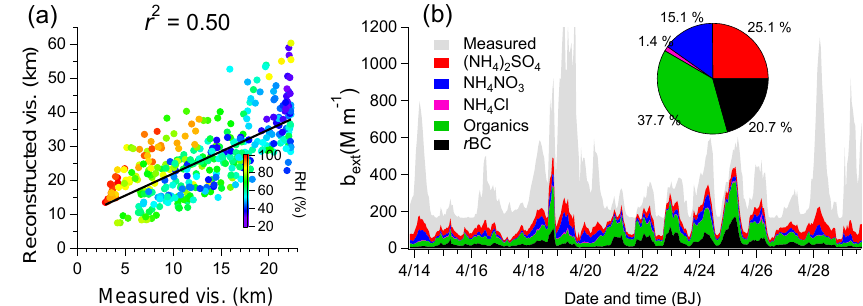
Figure 6. (a) Scatter plot of reconstructed vs. measured visibility (colored by RH), (b) light extinction coefficients derived from measured visibility (gray), and reconstructed from SP-AMS measured ammonium sulfate, ammonium nitrate, ammonium chloride, organics and r BC using the IMPROVE method. The inset pie shows the relative contributions of the five species to the light extinction of PM 1 .